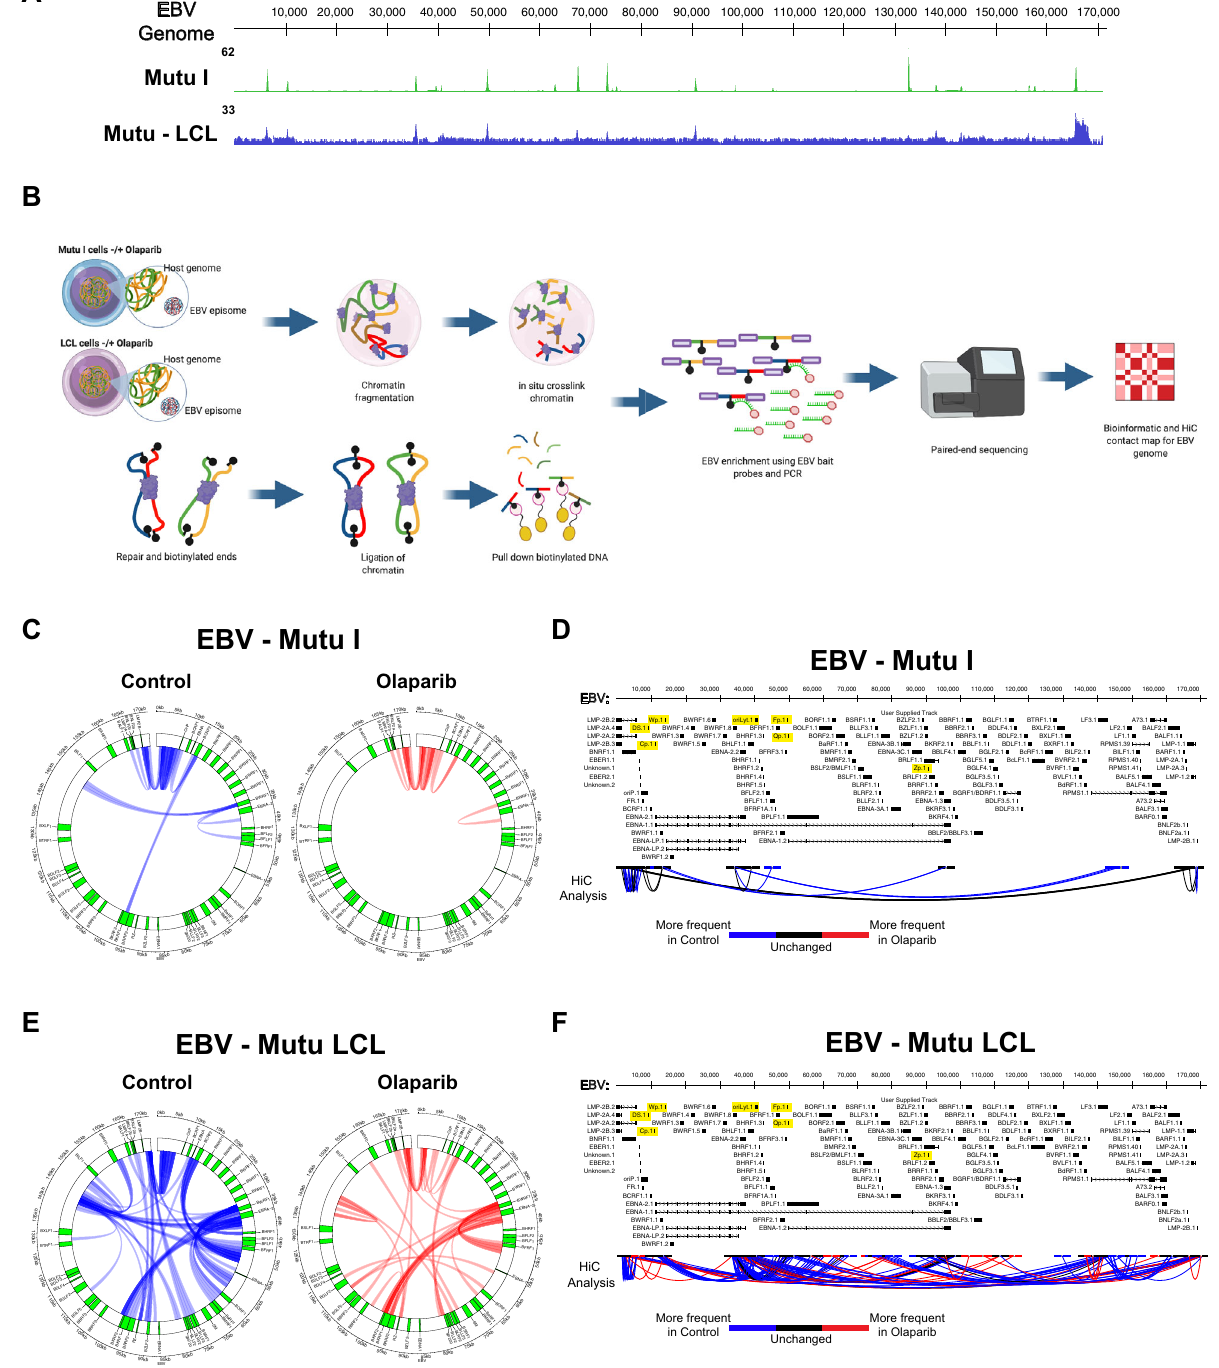
Fig. 1 EBV 3D chromatin conformation is altered by latency type and PARP inhibition. A CTCF ChIP-seq pro fi les in human EBV + B-cells with type I latency (Mutu, green) or type III latency (LCL, blue), normalized to input chromatin. B Schematic of HiC work fl ow followed by EBV enrichment and sequencing. The fi gure was created with BioRender. C Circos graphs of all DNA-DNA contacts with the signi fi cance of <0.05 within the type I latency EBV genome (Mutu) derived from HiC matrices. The left circos graph represents the control (untreated genome, blue) and the right represents the type I genome with 2.5 µ M olaparib treatment (red). D Linearized type I EBV genome (Mutu) with arcs connecting DNA-DNA contacts derived from HiC matrices. Blue arcs represent chromatin loops that are more frequent in the control genome, red arcs represent chromatin loops that are more frequently observed in the olaparib treated genome, and black arcs are loops that are unchanged between control and treatment. E Circos graph (as described in ( C )) for untreated (left, blue) and olaparib treated (right, red) type III EBV genome (LCL). F Linearized type III EBV genome (LCL) as described in ( D